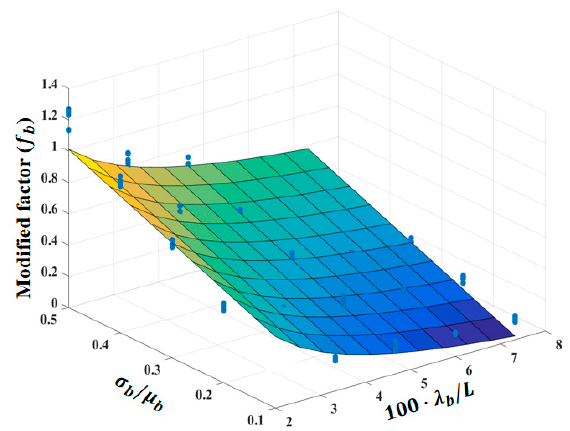
Figure 12. Plot of 75 triples of f b , σ b / µ b and λ b / L for 75 fracture models in the three groups and a fitted surface.